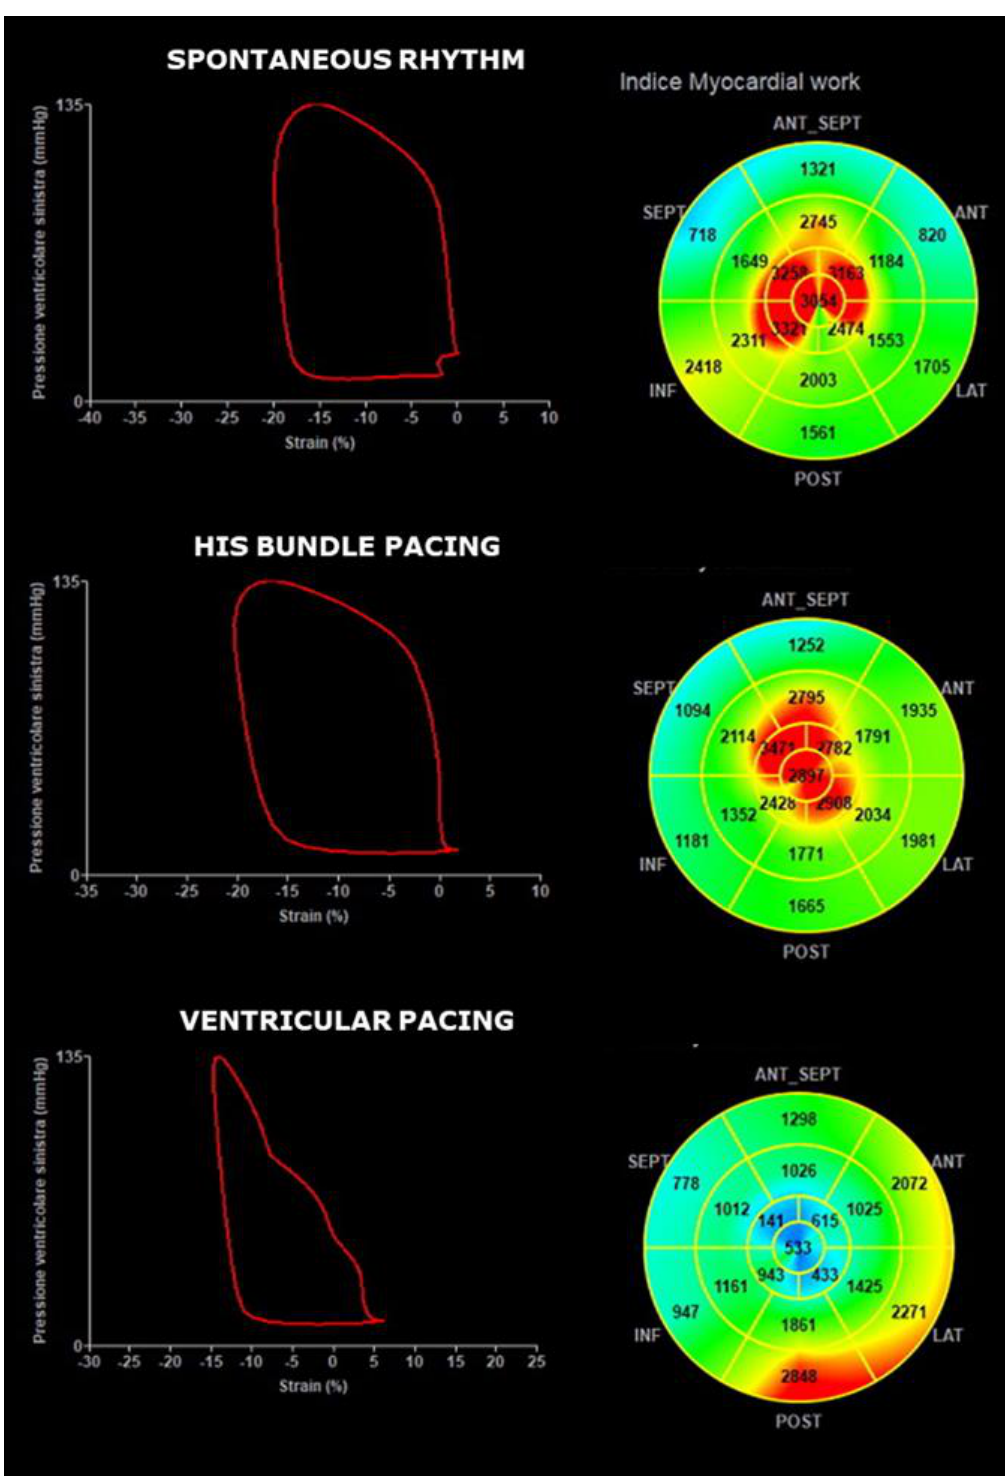
Figure 3. Pressure strain loops and global longitudinal strain bulls-eye showing the difference in left ventricular activation between spontaneous rhythms, His bundle pacing and right ventricular pacing.